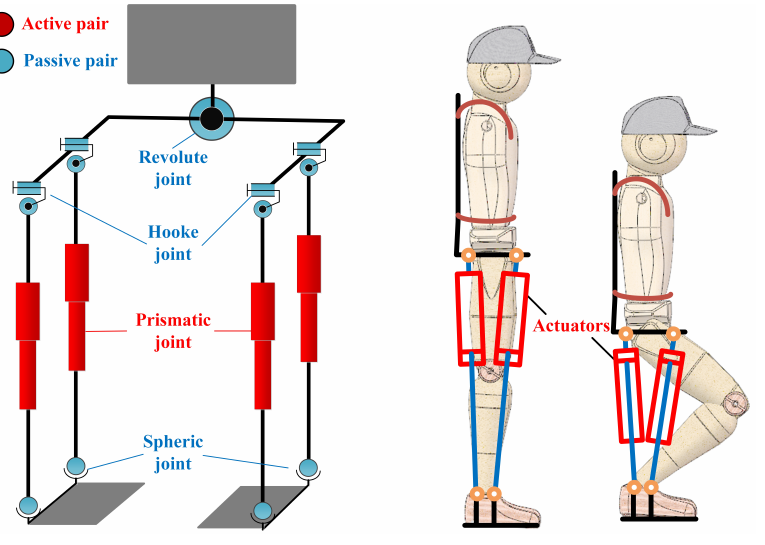
Figure 1. DOFs arrangement of PALExo. Exoskeletons, attached to human limbs when working, are a specific type of robot meant for interaction with human limbs. Therefore, exoskeletons are supposed to be lightweight and compliant. Moreover, weight-bearing exoskeletons, meant for carrying a heavy load for humans, are expected to have significant power, extending human